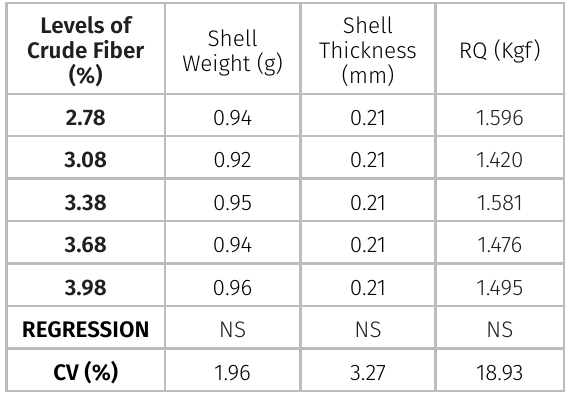
REGRESSION NS NS NS CV (%) 1.96 3.27 18.93 NS = non-significant for regression analysis (p>0.05); L* = Linear Regression; Equation: Y = 4.4907+ 0.1437 X; p = 0.02; CV = coefficient of